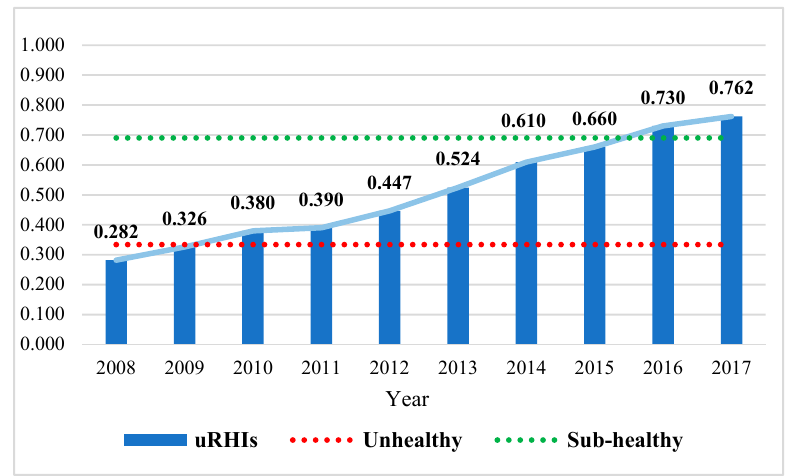
uRHI trend from 2008 to 2017. Figure 6. Jialu River uRHI S S trend from 2008 to